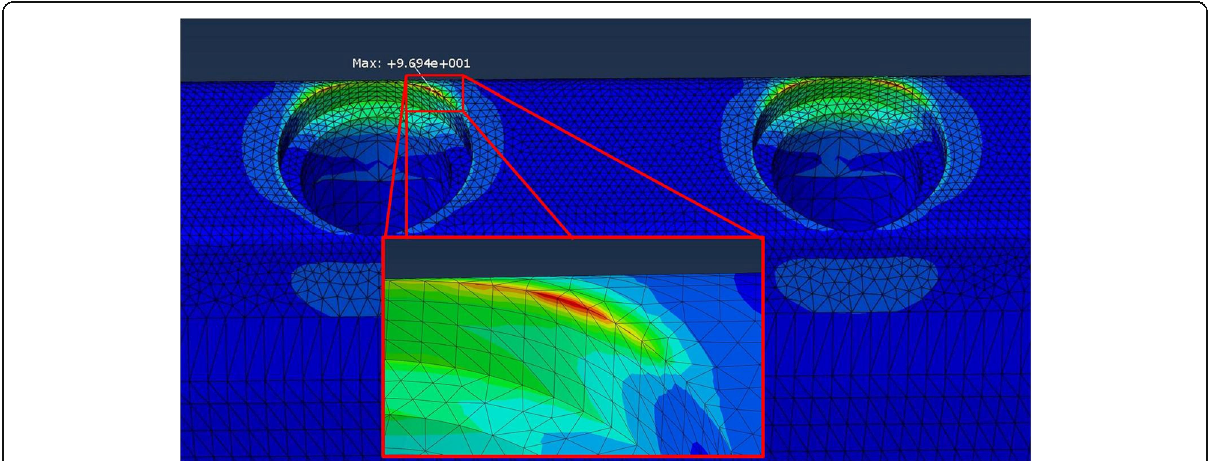
Fig. 3 Location of the areas where the highest stresses were predicted in the bone part and magnification of one of those four areas of interest. Location and value of the highest stress computed for the bone part (96.94